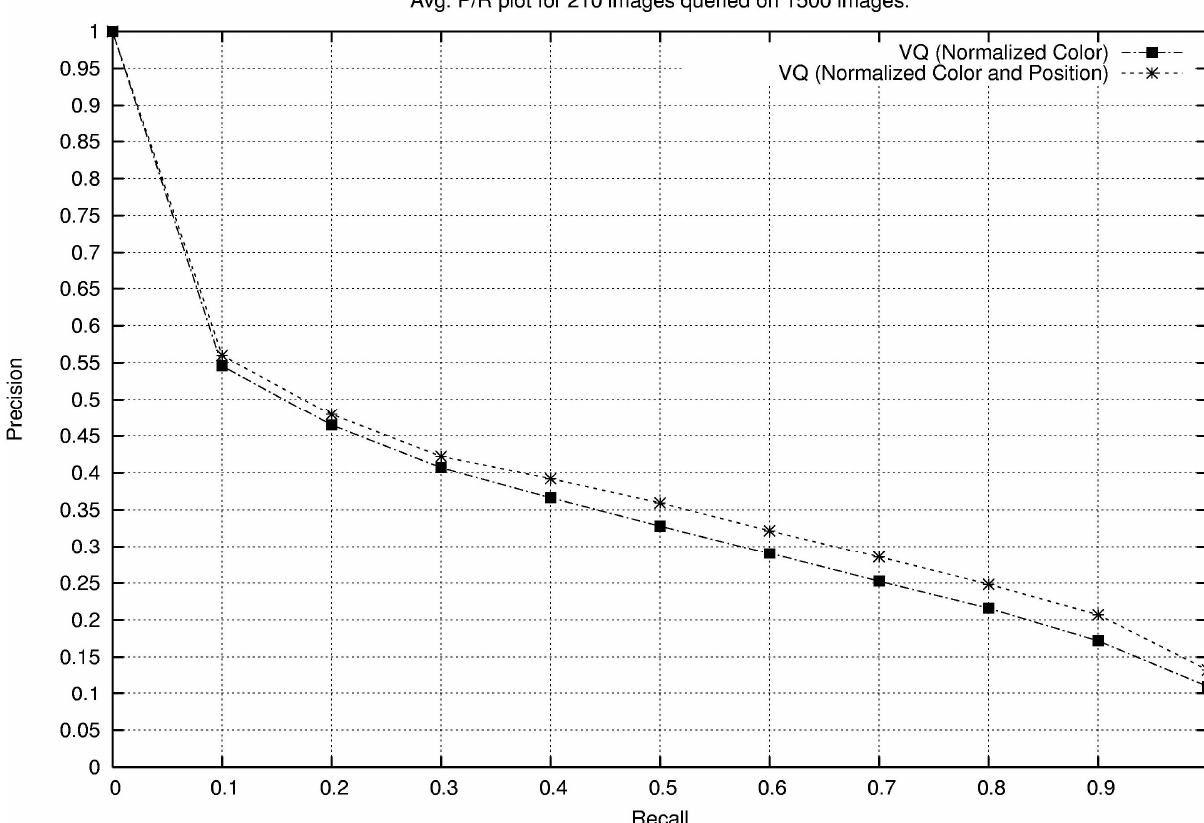
Figure 5. VQ with color only vs. VQ with color and